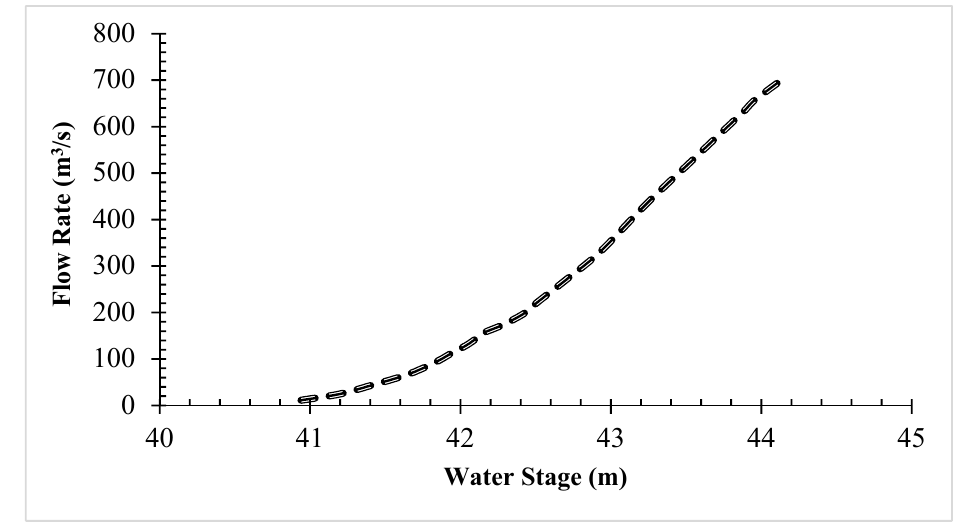
Figure 7. Stage-discharge relationship at Hsin-Pu Bridge for base flow calculation.